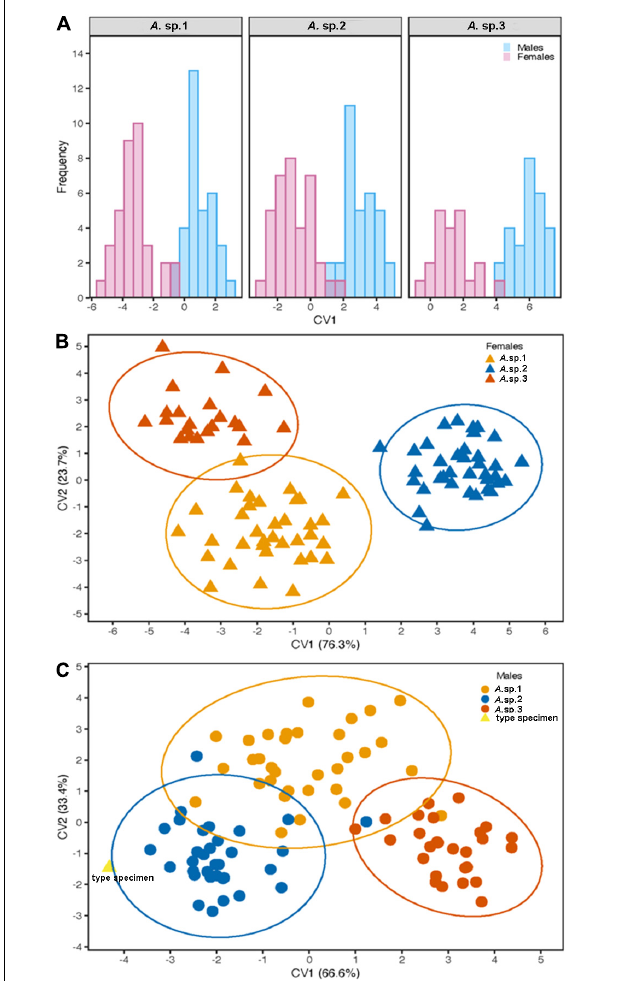
FIGURE 5 | Wing shape of the AF complex. (A) Canonical Variate Analysis based on the wing shape, revealing the separation between males and females for each species, using the scores of the CV1. (B,C) Scatterplot of the specimens, as results of the CVA used to segregate three morphotypes found in Brazil: (B) female discrimination; (C) male discrimination, including the type specimen near A . sp.2 according to the predictive model. Circles indicate confidence intervals at 95%.